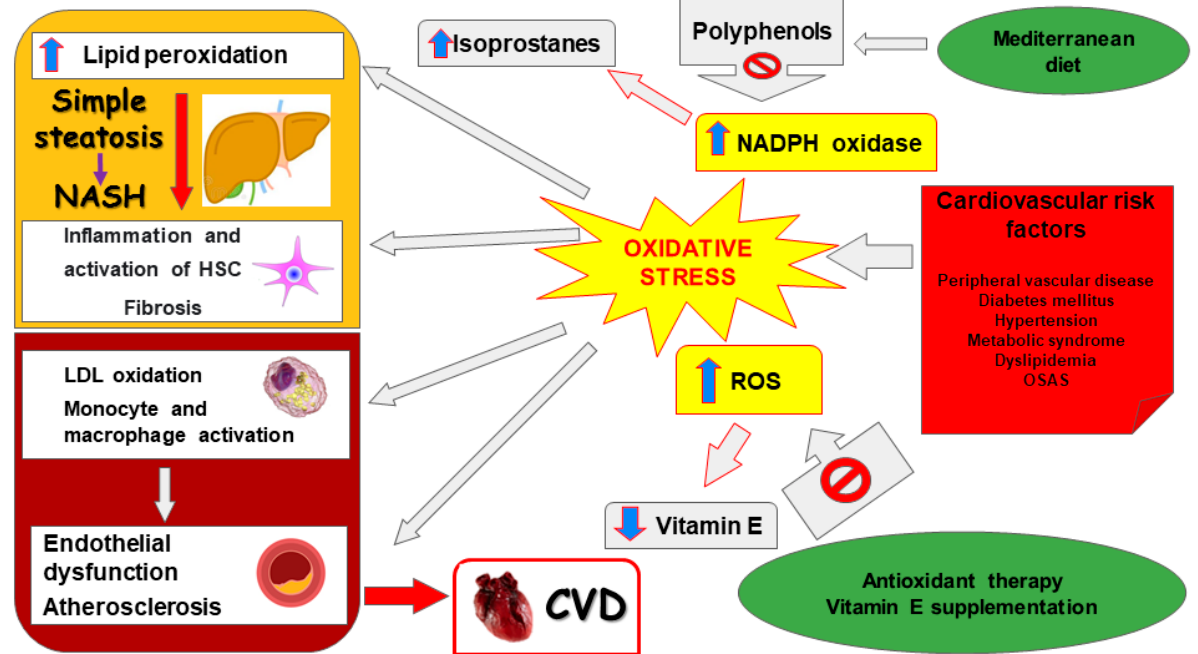
Figure 1. Possible pathophysiological effects of oxidative stress in NAFLD and cardiovascular dis- eases. NAFLD: non-alcoholic fatty liver disease; NASH: non-alcoholic steatohepatitis; HSC: hepatic stellate cells; LDL: low-density lipoprotein; ROS: reactive oxygen species; NADPH: nicotinamide adenine dinucleotide phosphate; OSAS: obstructive sleep apnea syndrome; CVD: cardiovascular disease.